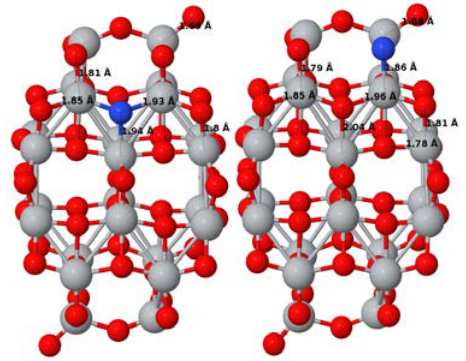
Fig. 2. Optimized N-doped TiO 2 anatase nanoparticles. The larger gray spheres are Ti atoms and the small red and blue ones represent O and N atoms, respectively.